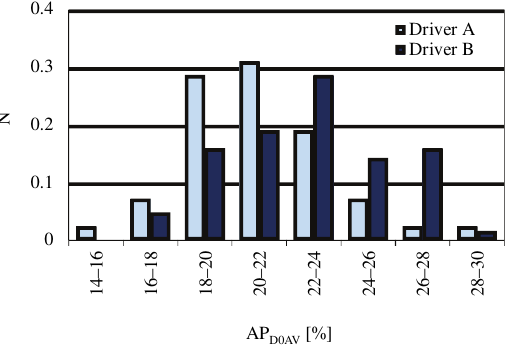
Fig. 25. Average relative position of accelerator pedal, excluding vehicle stops, in extra-urban driving conditions